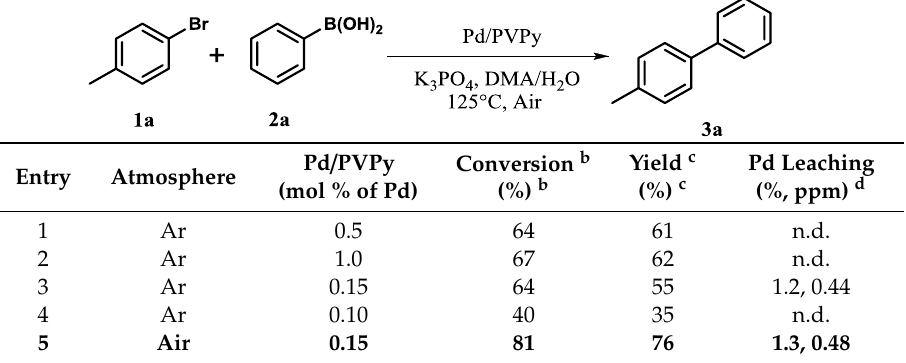
Table 1. Suzuki–Miyaura reaction catalyzed by the Pd/PVPy catalyst a .